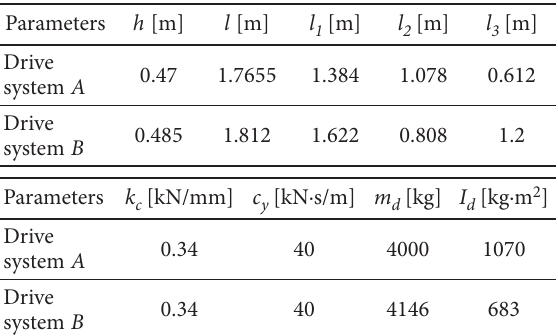
Fig. 19. The suspension frequency of drive system